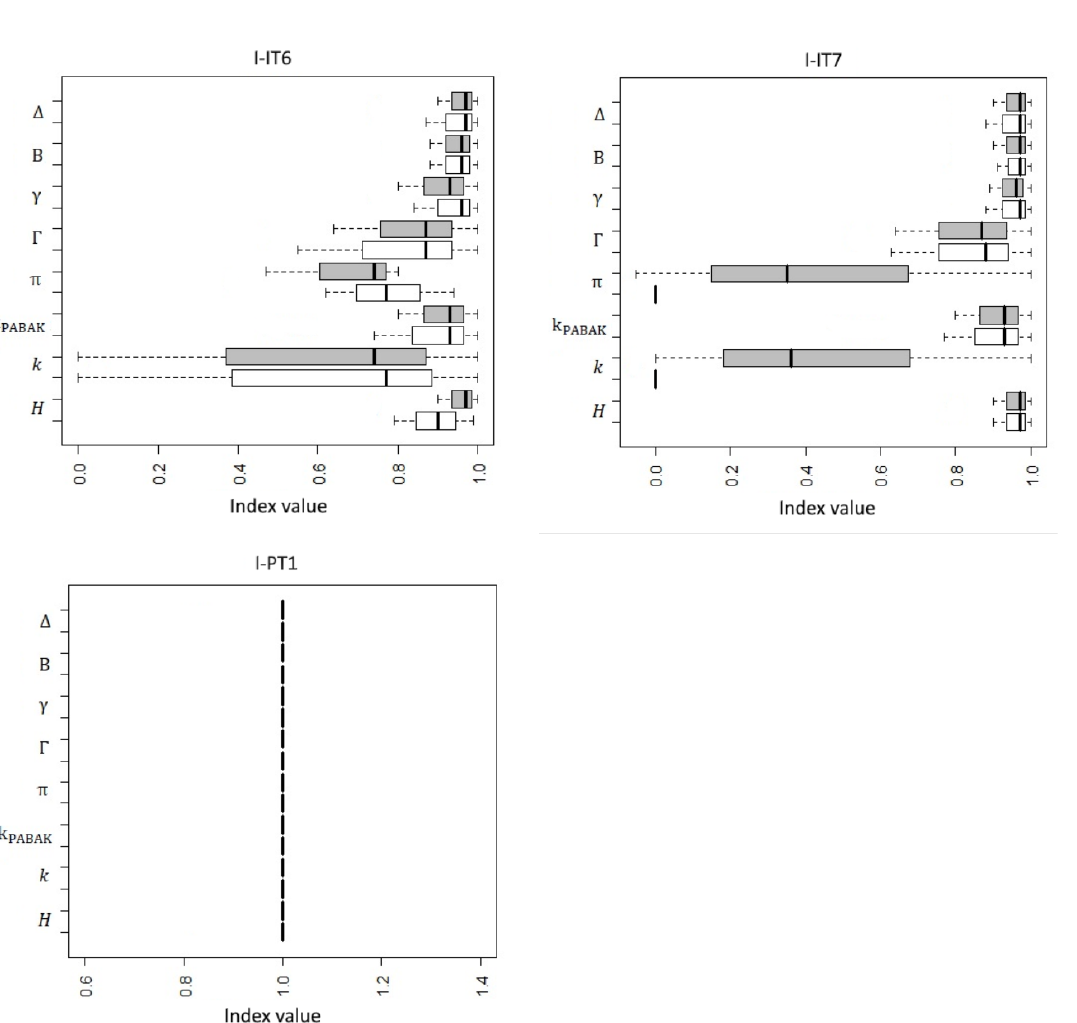
Figure 1. Boxplot of the agreement values obtained for each index with the bootstrap method and the exact bootstrap method for all the selected farms (I-IT1, E-IT1, I-IT2, I-IT3, I_IT4, I_IT5, I_IT6, I-IT7, I-PT1). Legend: ∆ = ∆ index; B = B index; γ = γ ( AC 1 ) index; Γ = Γ index; π = π index; k PABAK coincided with the related indexes: σ index, G index and S index; k = k index; H = H index; grey = bootstrap method; white = exact bootstrap method. The α index is not reported in the figure as it coincided with Cohen’s k . The J index is not reported in the figure as it coincided with Hubert’s Γ